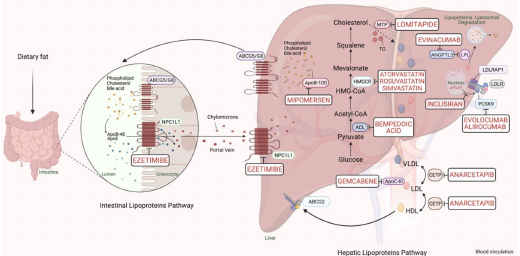
Figure 1. Scheme representing the cholesterol metabolism pathway and pharmacological targets for classical and novel lipid-lowering therapies (generated with BioRender.com). Unique hepatic and intestinal transporters (ABCG5 and ABCG8) release bile acids, phospholipids, and cholesterol into the biliary system. Inversely, the NPC1L1 protein modulates cholesterol returning to hepatocytes. Ezetimibe inhibits cholesterol entry into the intestine and liver by the NPC1L1 transporter. Next, chylomicrons are generated through the assembly of TG, cholesterol, and ApoB-48, and released into the blood circulation (see intestinal lipoproteins pathway). The speed-limiting enzyme of endogenous cholesterol synthesis, HMGCR (see hepatic lipoproteins pathway), is inhibited via statins. The activated bempedoic acid decreases the hepatic synthesis of acetyl CoA and cholesterol catabolism by blocking the ACL protein. ApoB-100, phospholipid, ApoC-III, and cholesterol assembly into VLDL depends on the activity of MTP, which is blocked by lomitapide. The degradation of hepatic messenger ribonucleic acid (mRNA) transcript of ApoB-100 and ApoC-III is mediated by mipomersen and gemcabene, respectively. The heteroexchange of TGs and cholesteryl esters between ApoB-lipoproteins particles relies on CETP activity, which is blocked by CETP inhibitors such as